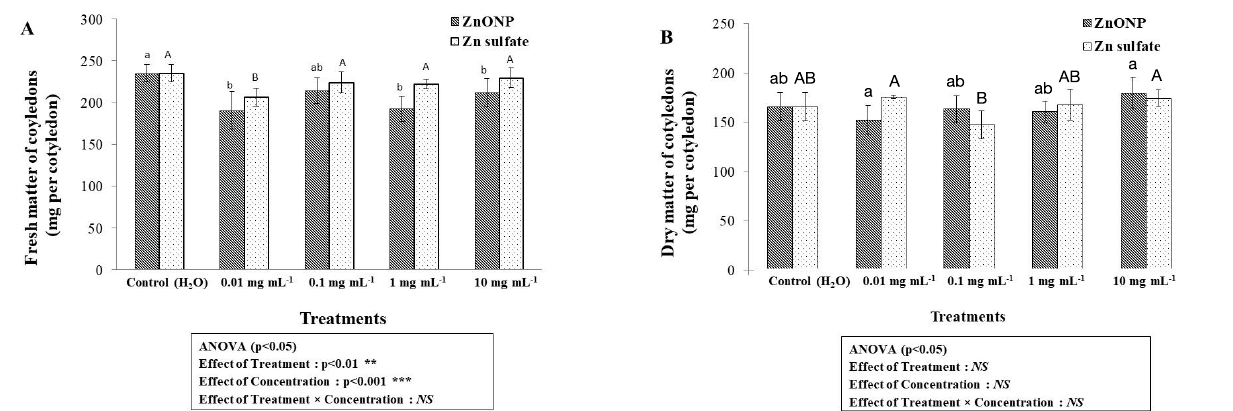
Fig. 4 Fresh matter (A) and dry matter (B) of the cotyledons of Lathyrus sativa L. seeds germinated for 4 days in the presence of distilled water (Control) or solutions of ZnO NPs and ZnSO 4 at concentrations 0.01 mg ml -1 , 0.1 mg ml -1 , 1 mg ml -1 and 10 mg ml -1 . Values are means (±SD) of 5 independent measurements. Letters a-c and A-C denote statistic classes, respectively, for ZnO NPs and Zn sulfate, using Duncan test (α=0.05). Differences are significative, at *: 0.01≤P<0.05, **: 0.001≤P<0.01, ***: P<0.001, and non significant NS at